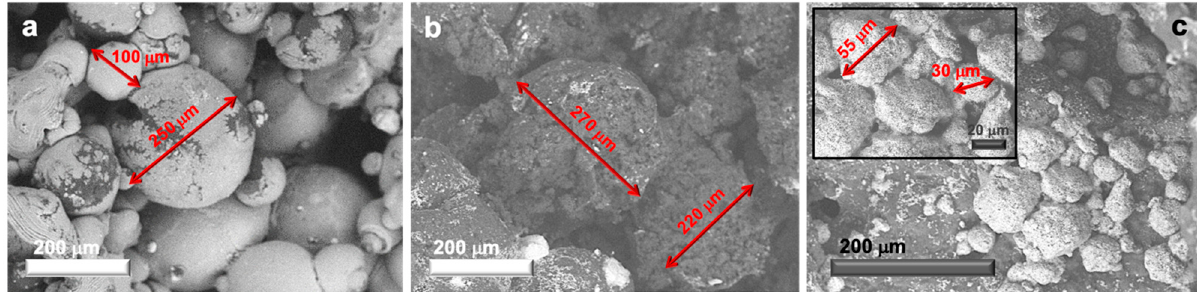
Figure 3. Scanning electron microscopy (SEM) micrographs displaying the actual capsules size (highlighted with red arrows) relative to: ( a ) MC(BUMA_MA), ( b ) MC(BUMA_MA_MMA_T3) and ( c ) MC(BUMA_MAC_75) (inset: high magnification image).